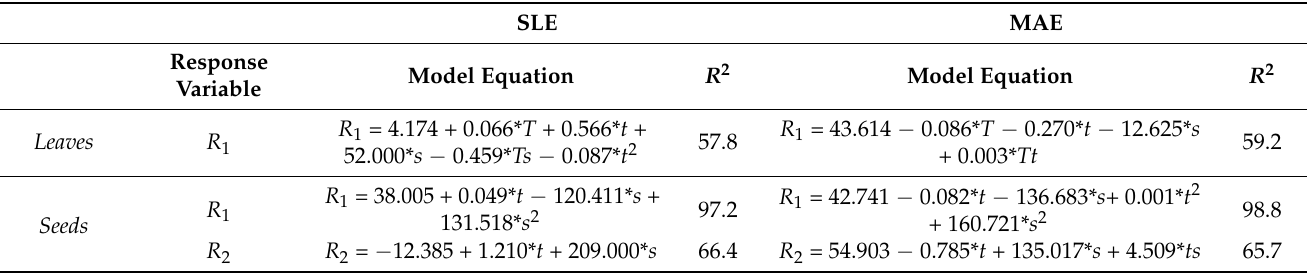
Table 2. Regression equations to maximize the extraction of inositols ( R 1 ) and α -GOS ( R 2 ) from leaves (Lv2) and seeds (Sd2) by solid-liquid extraction (SLE) and microwave assisted extraction (MAE). SLE MAE